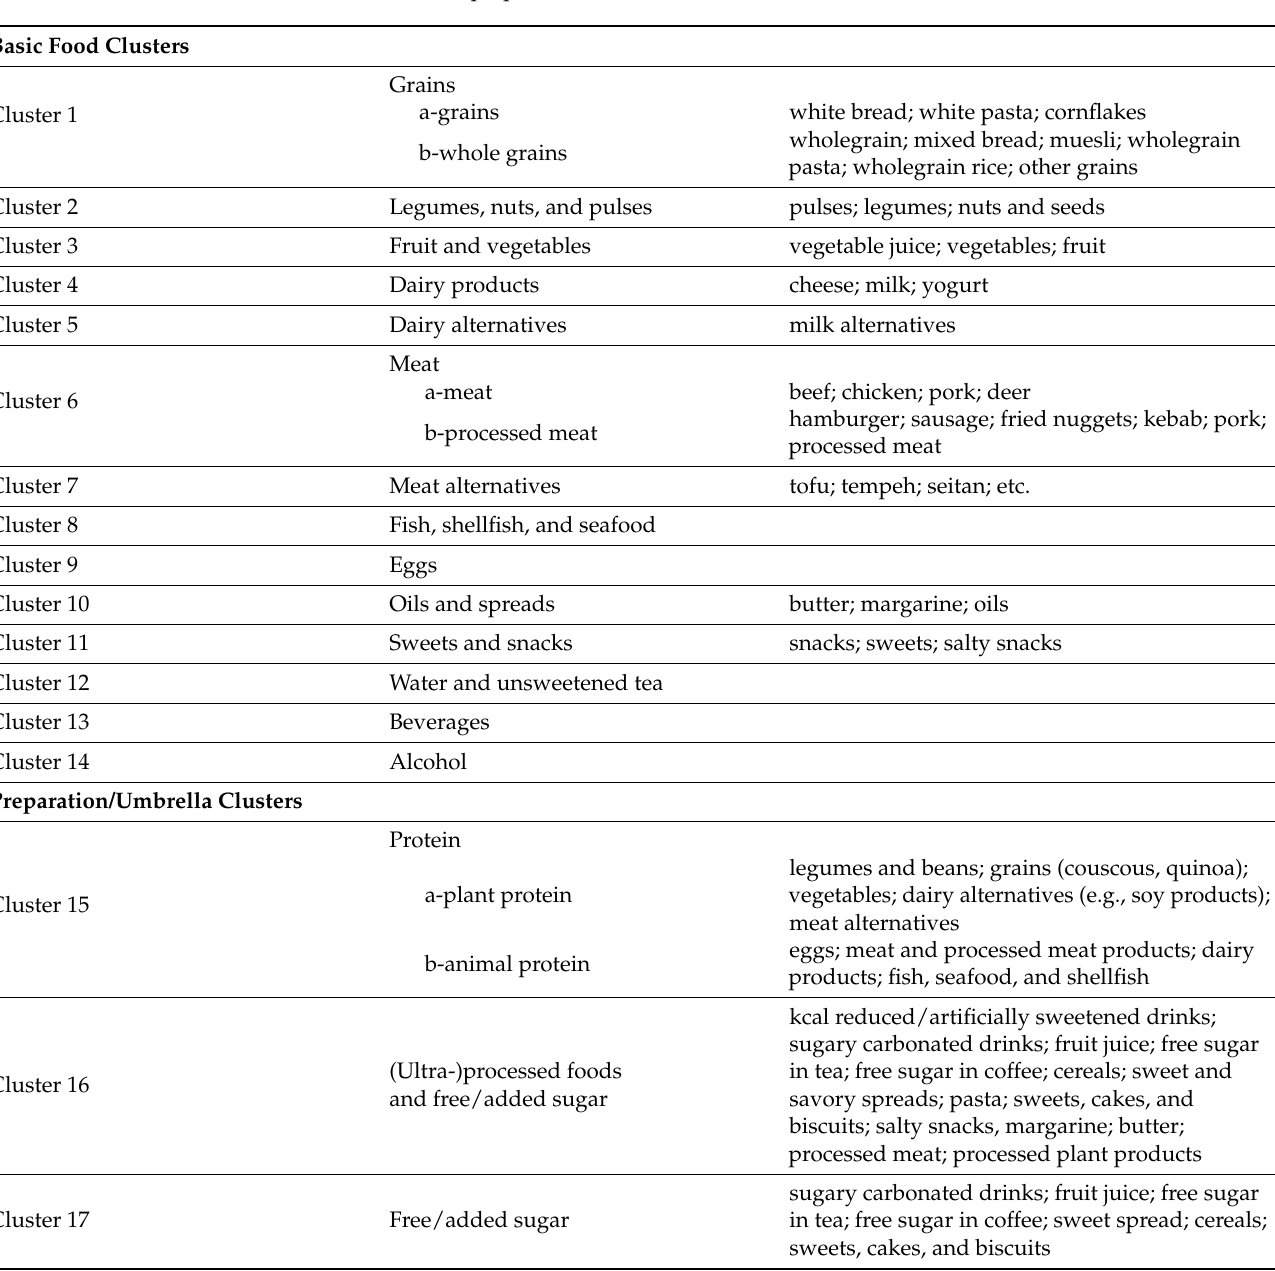
Table 1. Modeling of food items, groups, and clusters (including 14 basic consumption clusters along with 3 umbrella/preparation